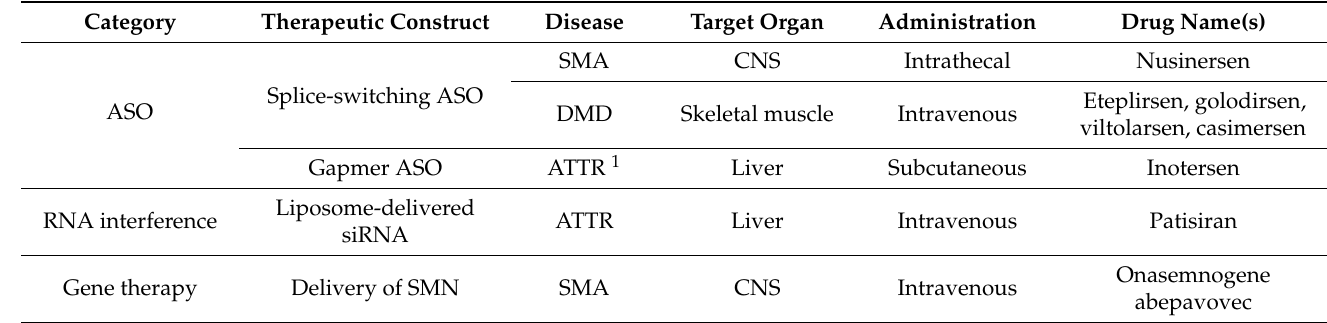
Table 1. Approved nucleic acid therapeutics for neurological